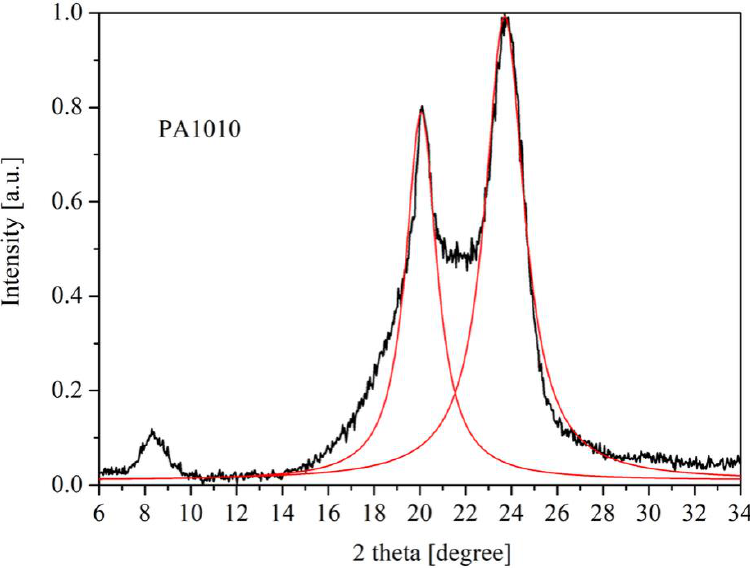
Figure 8. XRD pattern of neat PA1010. The red solid lines are the Lorenz fitting of α and γ diffraction planes.